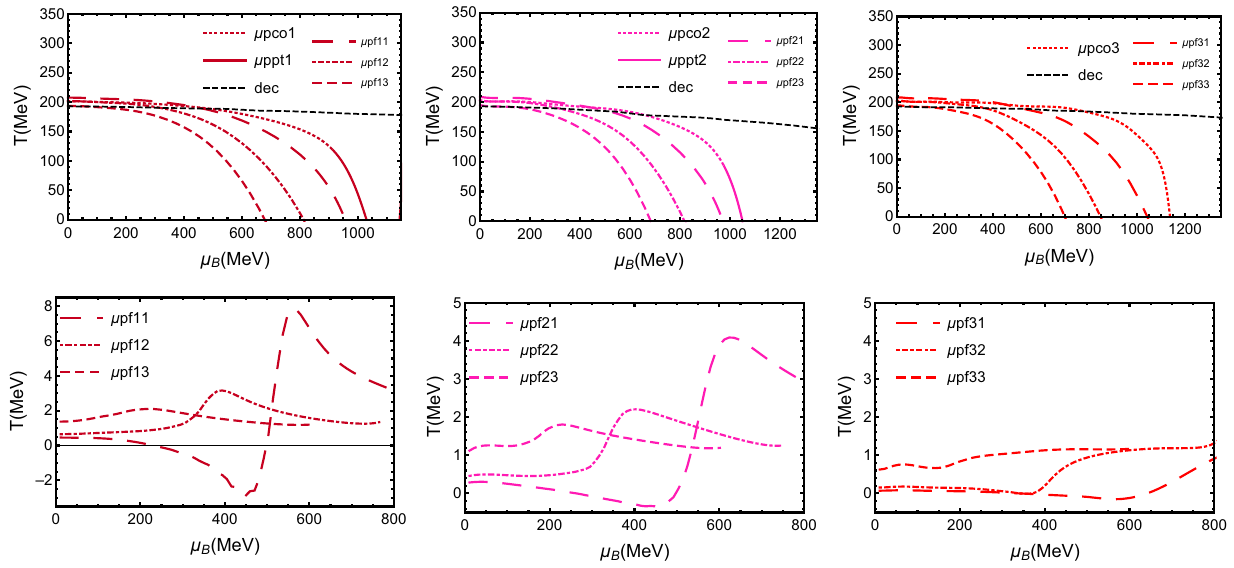
μ pfI2 starts from the back ridge of the deconfinement phase boundary, and then crosses the foot of the CEP mountain; (3) μ pfI3 starts from the deconfinement phase boundary and keeps far away from the CEP mountain. These three different freeze-out lines are indicated by long dashed, dashed-dotted and dashed lines, respectively. (Below) The 2D plotfor κσ 2 asafunctionofthebaryonchemicalpotentialinthe μ PNJL model along three freeze-out lines